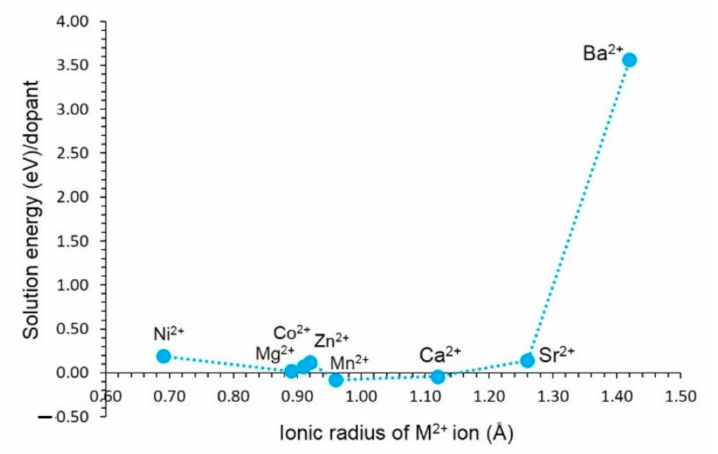
Figure 4. Solution energy of MO (M = Ni, Co, Mn, Mg, Zn, Ca, Sr, and Ba) with respect to the M 2+ ionic radius.